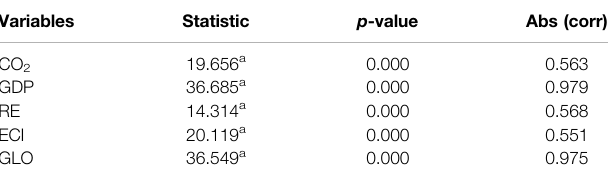
TABLE 2 | Pesaran (2015) Cross-sectional dependency test results. TABLE 3 | Slope homogeneity test results.